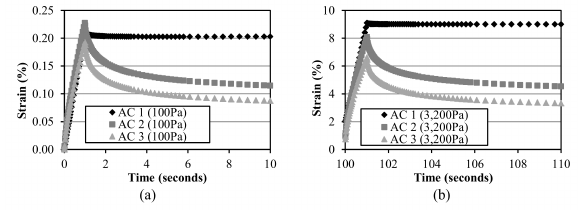
Figure 3: Superpave rutting parameter: (a) unaged and (b) RTFOT- aged specimens